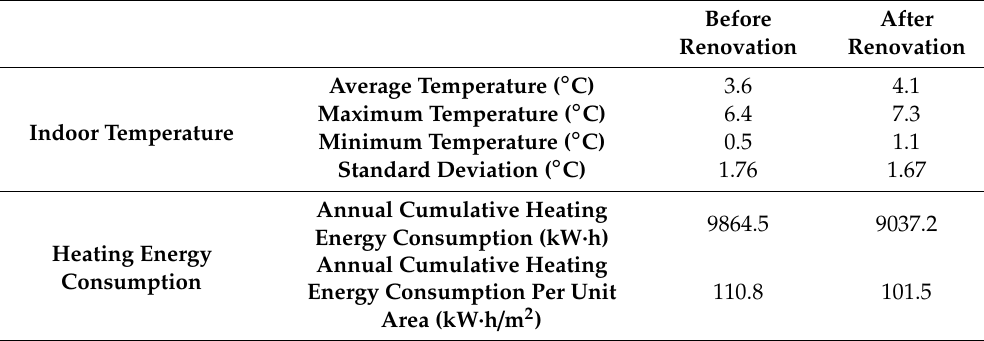
Figure 15. The annual cumulative heating energy consumption before and after building the sunspace. Table 5. The data comparison of temperature and energy consumption before and after building the